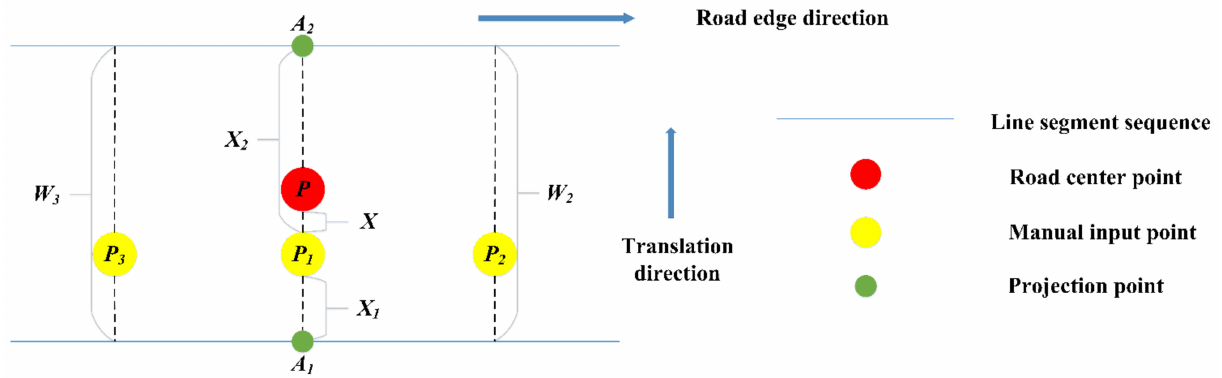
Figure 4. Adaptive road width extraction